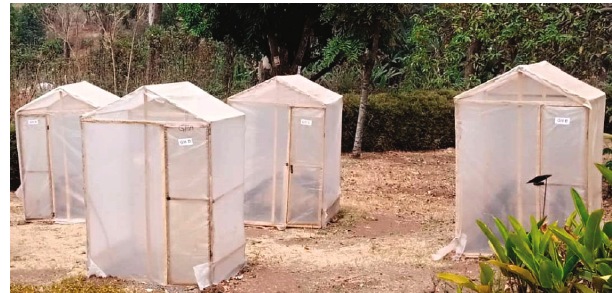
Figure 1: Constructed dryers used in the cocoa bean